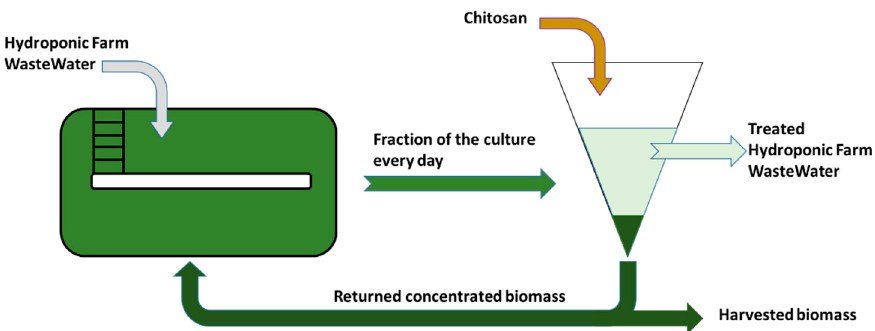
Figure 4. Integrated continuous process to treat HFWW using HFWWC.